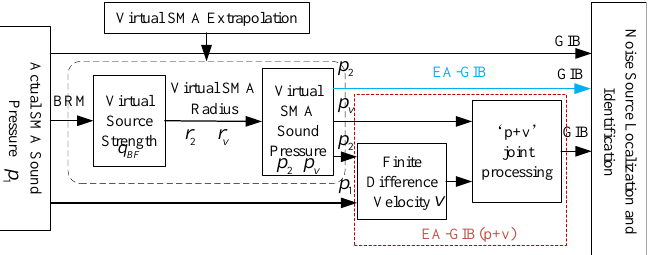
Figure 4. Schematic diagram of the virtual SMA noise source localization and